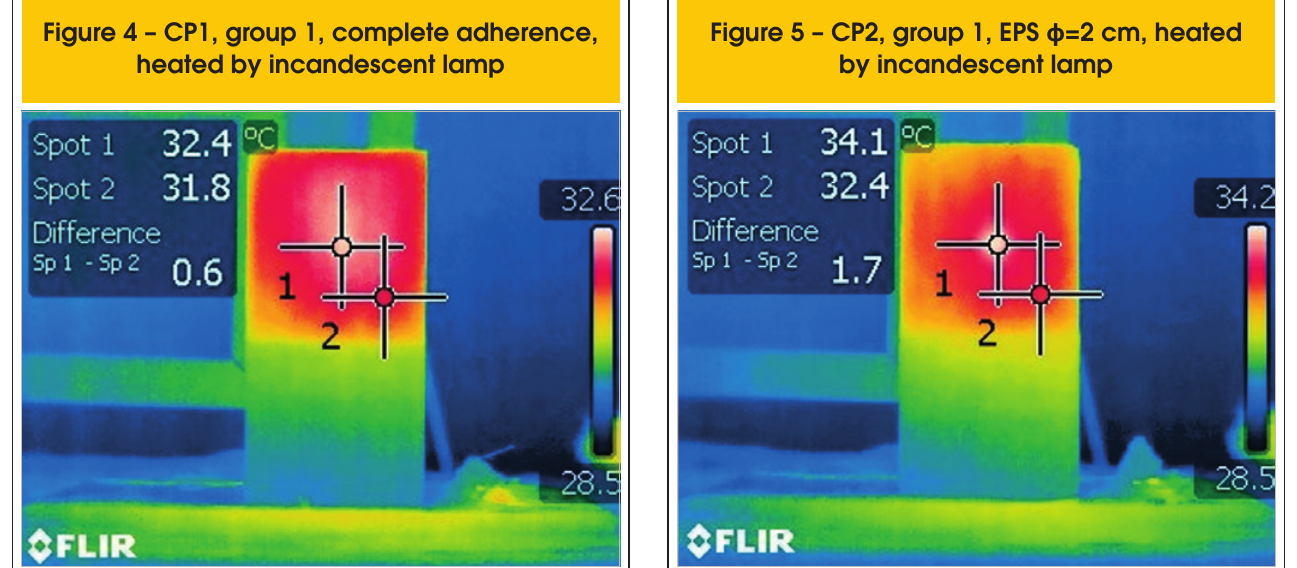
Figure 4 – CP1, group 1, complete adherence, heated by incandescent lamp